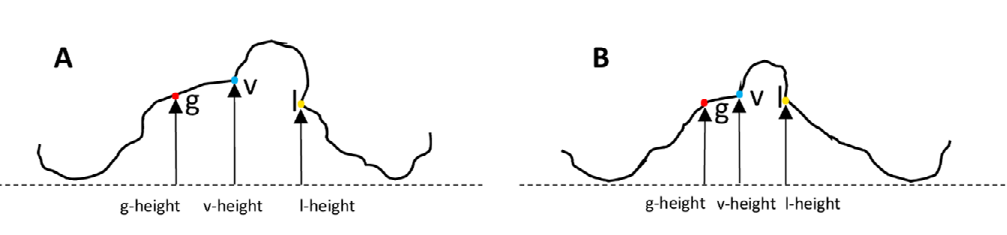
Figure 7. Cross-section through GM and LM perpendicular to the horizontal plane, displaying the height of g, v, and l above the horizontal plane at T0 ( A ) and T2 ( B height of g, v, and l above the horizontal plane at T0 ( A ) and T2 ( B ).